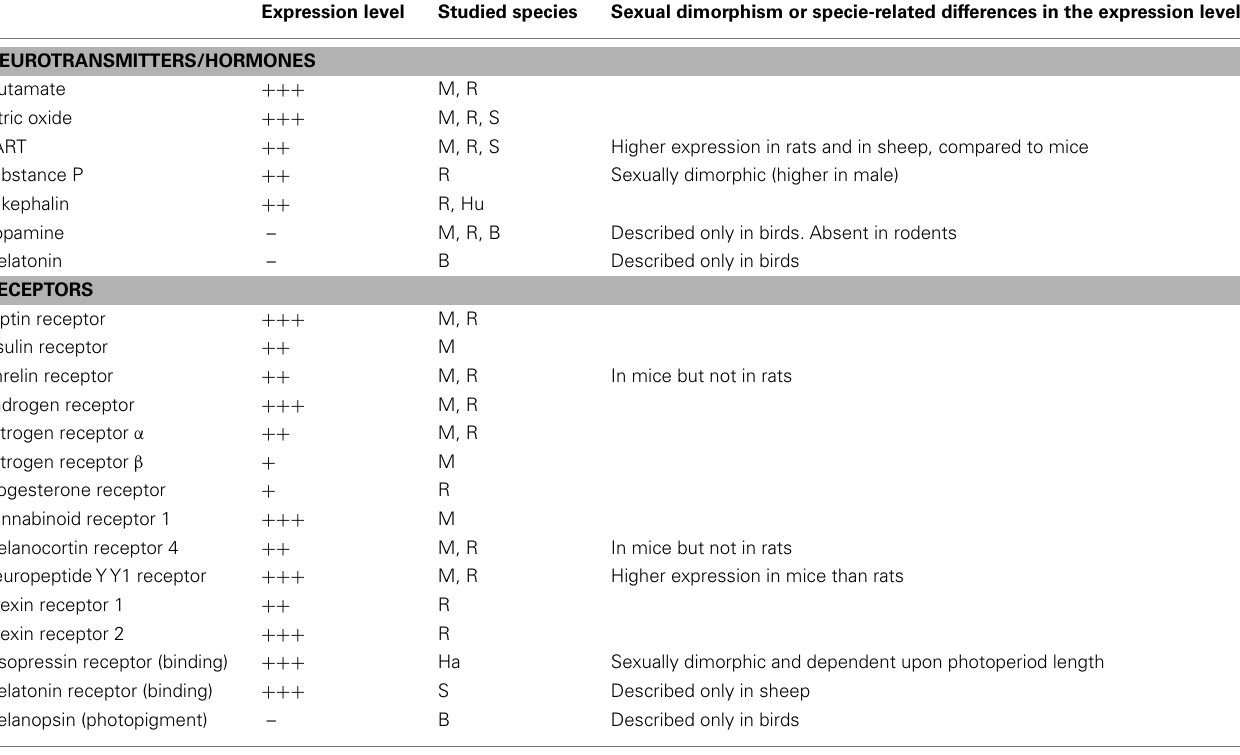
Table 1 | Neurochemical characteristics of the ventral premammillary nucleus